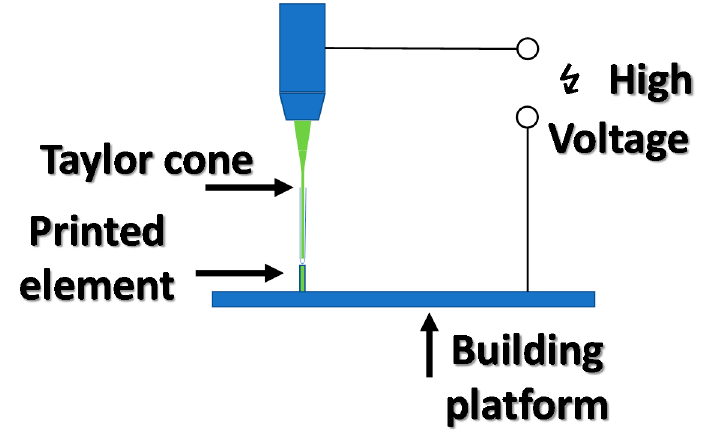
Figure 7. Electrohydrodynamic inkjet printing principle in operation.